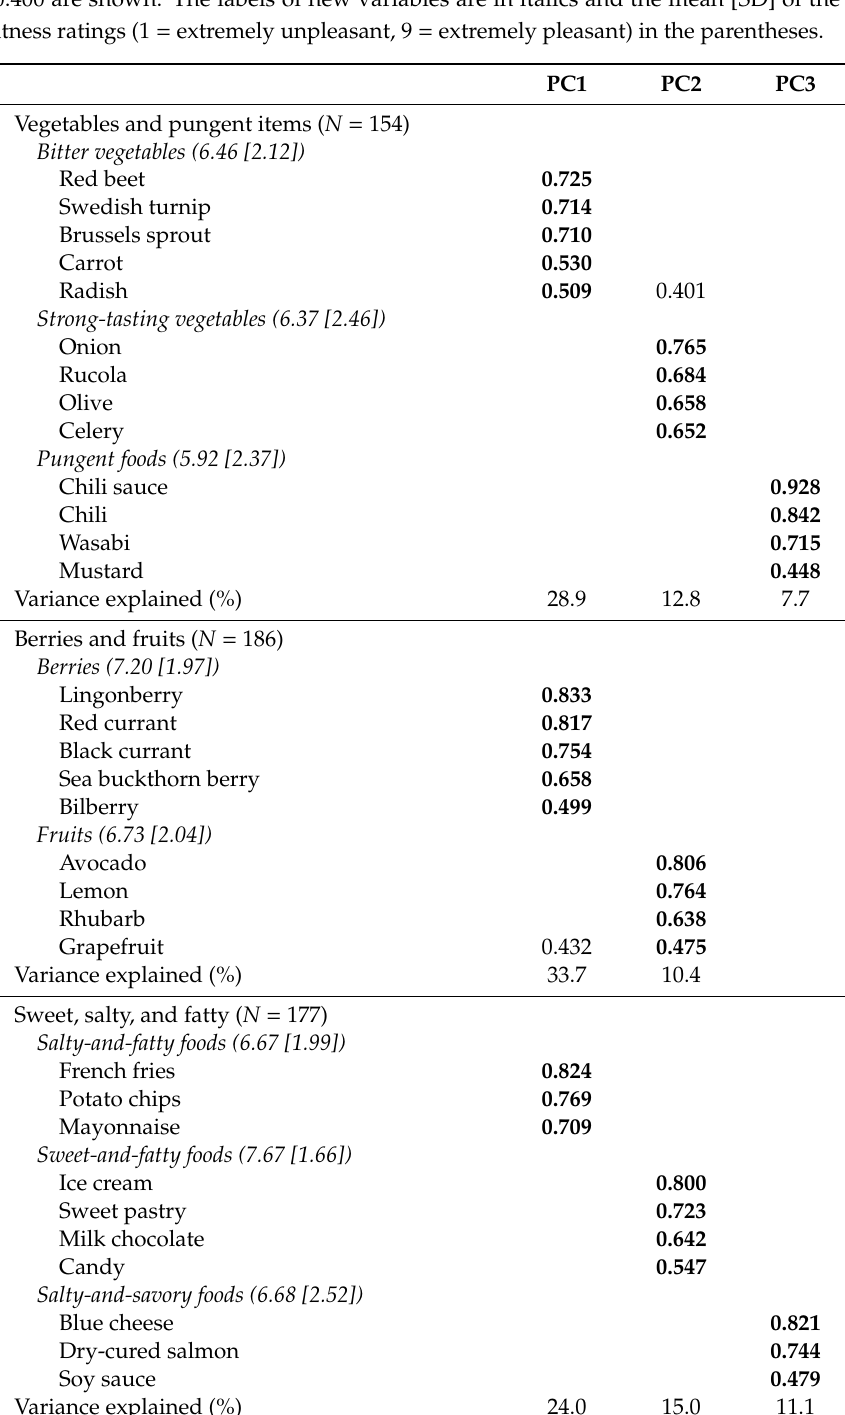
Table 4. Rotated variable loadings of the extracted pleasantness components (correlation coe ffi cients). The bolded coe ffi cient indicates the highest correlation of the item. For simplicity, only coe ffi cients above 0.400 are shown. The labels of new variables are in italics and the mean [SD] of the original pleasantness ratings (1 = extremely unpleasant, 9 = extremely pleasant) in the